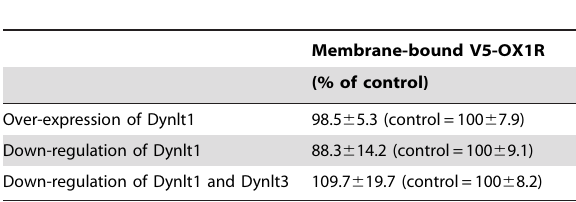
V5 tag added at the extracellular amino-terminus of OX1R allowed for the specific detection of membrane-bound OX1R in absence of permeabilization. Over-expression or down-regulation of Dynlt1 did not significantly change the level of membrane- bound OX1R (Table 1). In the latter experiment, presence of Dynlt3 could have compensated for the absence of Dynlt1, as both dynein light chains were found to interact with OX1R. However, no significant alteration of OX1R level at the membrane was detected upon application of siRNAs against both Dynlt1 and Dynlt3 (Table 1).